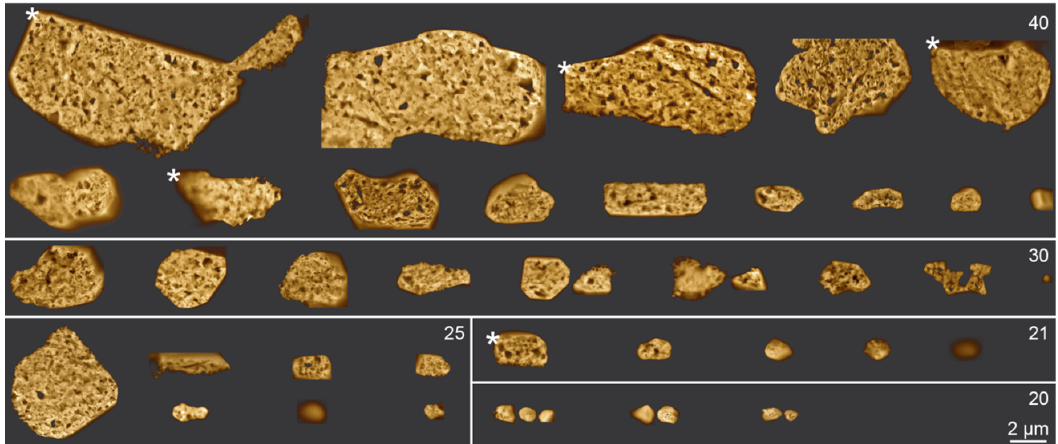
Figure 8. Secondary electron images of false-colored gold grains detected by the QEMSCAN ® analysis of Boliden AB for a range of signal intensity thresholds (20%–40%) of Au defined in the SIP-entry for the identification of Au minerals. A clear correlation between detectability and size exists. For the grains close to each other, they were marked by a single pixel in the mineral map and it was impossible to discern which had been hit by the electron beam. The grains with an asterisk were also detected by the QEMSCAN ® analysis of CSM.